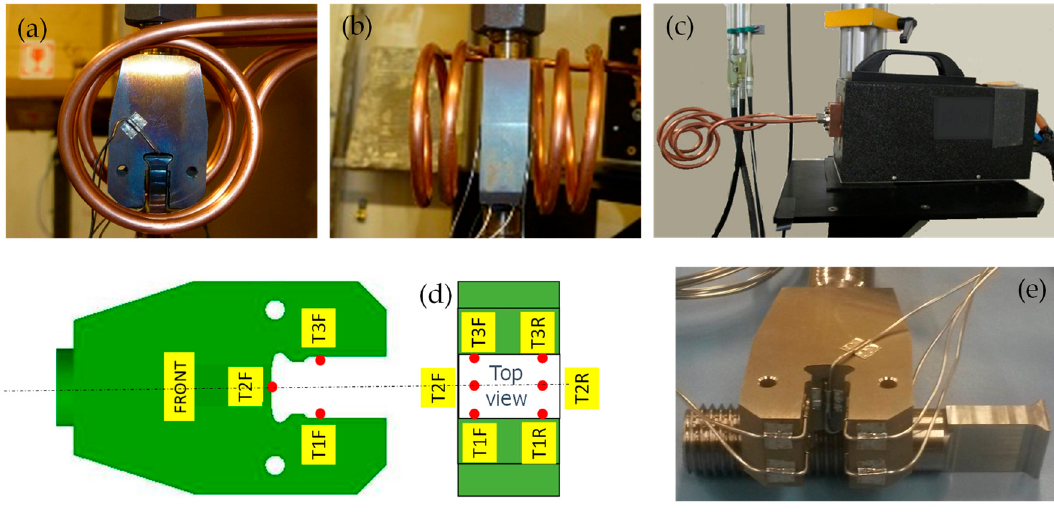
Figure 2. Heating coil setup front view ( a ) and side view ( b ); induction head with coil ( c ); sketch of thermocouple placement ( d , e ).